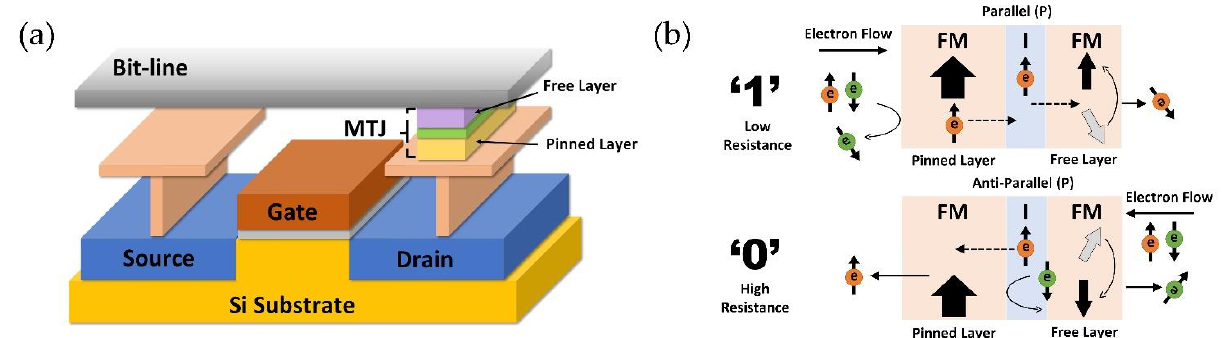
Figure 10. Schematic diagram of ( a ) MRAM cell and ( b ) TMR multilayer system at parallel and anti-parallel magnetizations.